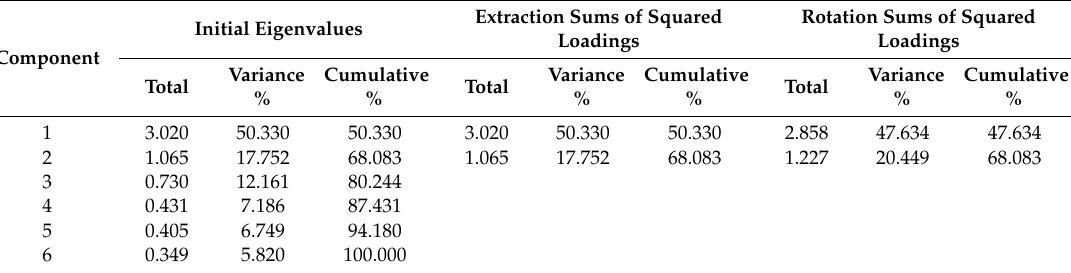
Table 4. Total explained variance.